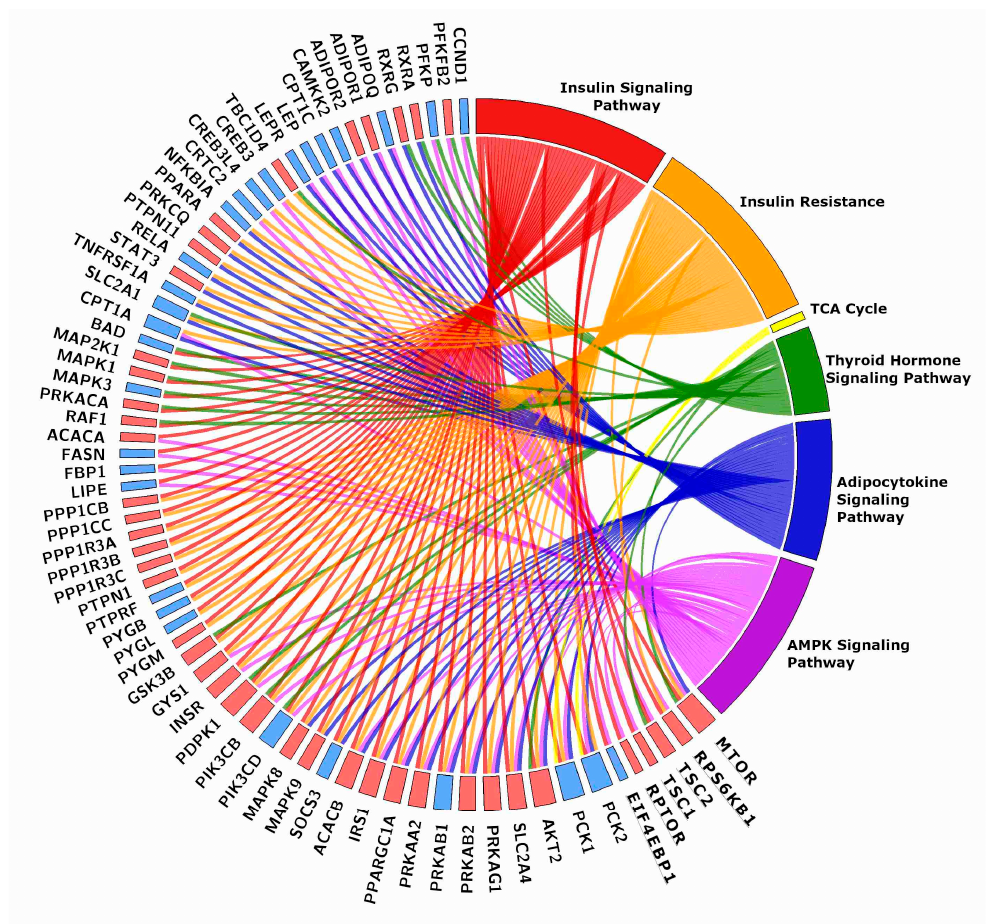
Figure 2. Chord plot showing the genes shared by two or more energy-related KEGGs. The rectangle flanking the gene name is red when the gene is more expressed in TRA than in SED VL, blue when it is less expressed. The plot includes six genes of the mTOR pathway, which were grouped together for clarity sake. Gene names and details on the pathways are in the text.